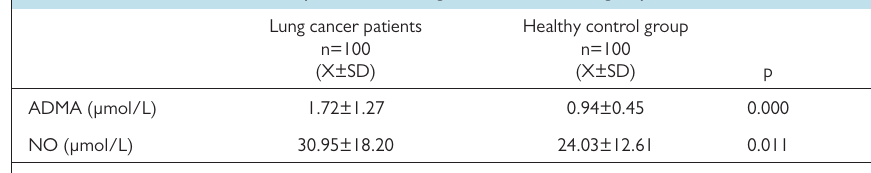
Table 2. ADMA and NO levels in patients with lung cancer and control group